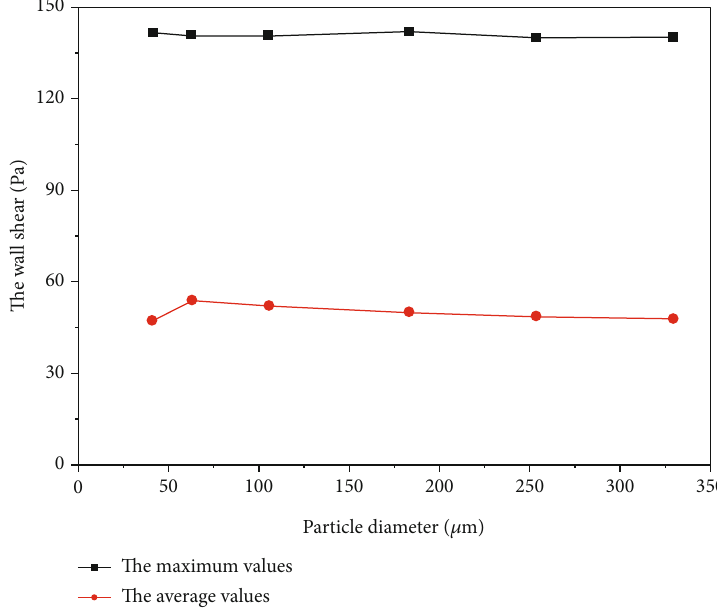
Figure 11: Variation of wall shear with the particle